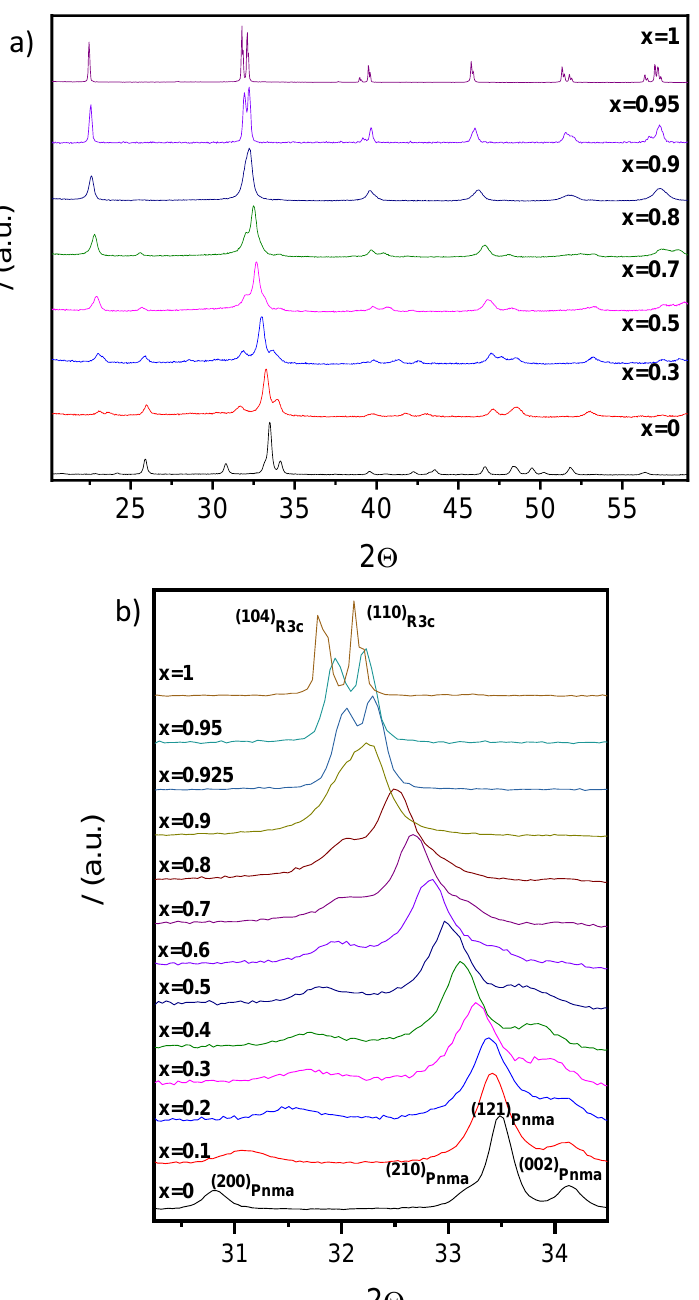
− x)YMnO Figure 3. XDR patterns of the (1 − x)YMnO 3 – xBiFeO 3 phases obtained by mechanosynthesis and Figure 3. XDR patterns of the (1 3 –xBiFeO 3 phases obtained by mechanosynthesis